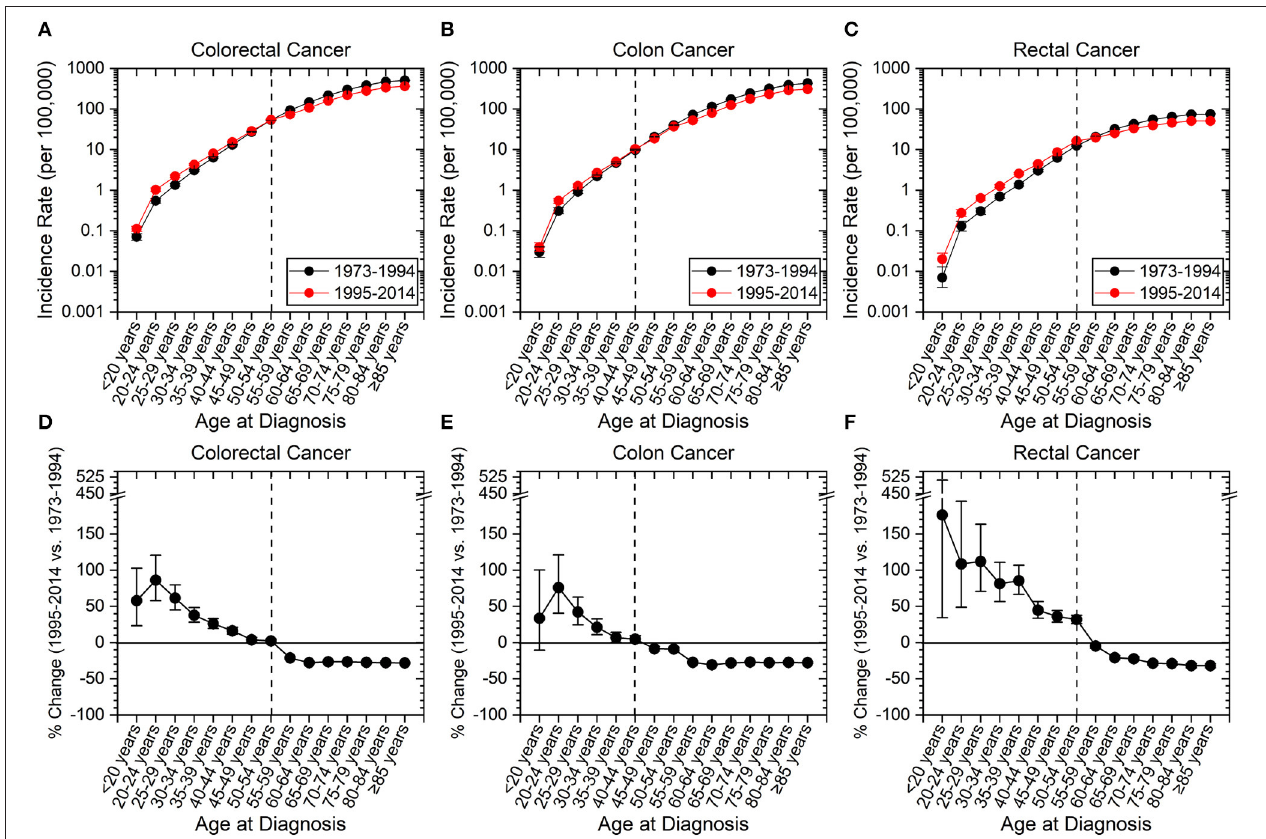
FIGURE 2 | Incidence rates of colorectal, colon and rectal cancers expressed as absolute numbers and as a percentage change from 1973–1994 to 1995–2014. Error bars represent 95% confidence intervals. Dashed line is to guide the eye to age range at which change in incidence rate converts from positive to negative. (A–C) Incidence rate of cancer as a function of site. (D–F) Percentage change of cancer incidence as a function of site. (A–F) Younger patients have seen an increase in cancer incidence, while older patients have seen a decline. Rectal cancer has seen the highest amplitude change compared to colon cancer and has a later age for transition from a positive to negative percentage